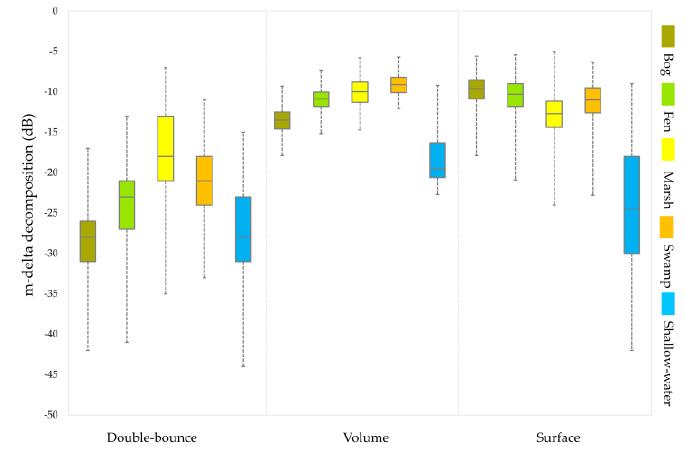
Figure 6. Box-and-whisker plots demonstrating the distribution of the SAR backscattering coefficients of CP SAR data for wetland classes obtained from the pixel values of the training data set. The red horizontal line highlights the nominal NESZ (-24 dB) of the RCM medium resolution mode.